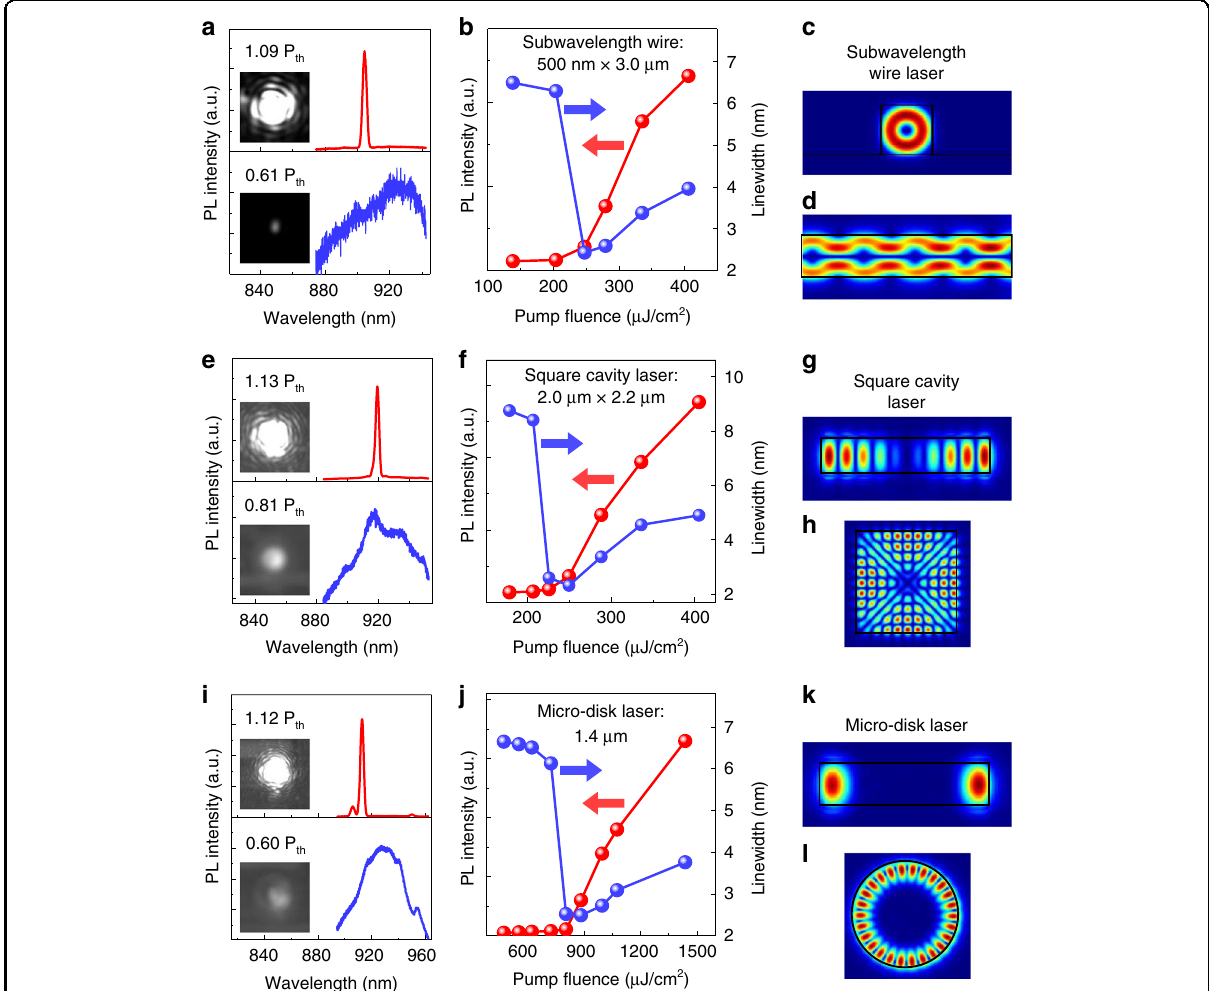
Fig. 6 Room temperature lasing of subwavelength wire, square cavity, and micro-disk lasers. a , e , i Room-temperature PL spectra of the subwavelength wire, square cavity, and micro-disk lasers, respectively. Inset shows the corresponding emission images below and above threshold. b , f , j Light – light (L – L) curve and linewidth narrowing of corresponding lasers. Calculated cross-sectional ( c , g , k ) and top-view ( d , h , l ) lasing mode pro fi les of the InP